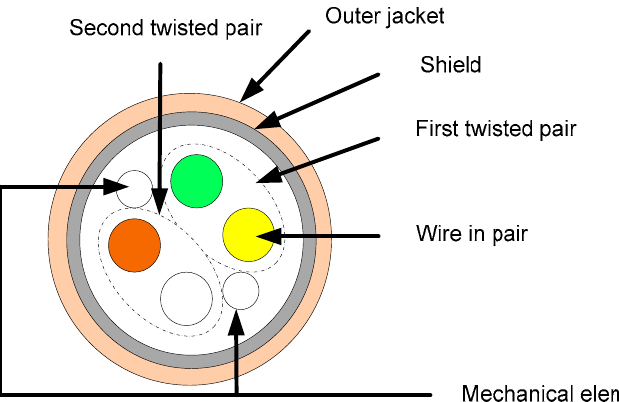
Figure 2. A simplified view of the cable under analysis.